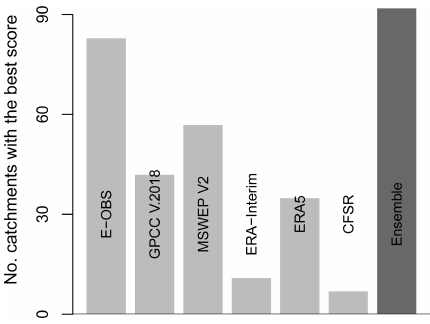
Figure 5. Number of catchments where each precipitation prod- uct yields the best agreement with runoff observations (May– September). Multiple data products can be best performing at a catchment since they are ranked based on a merged score by com- bining anomaly correlation and absolute error.